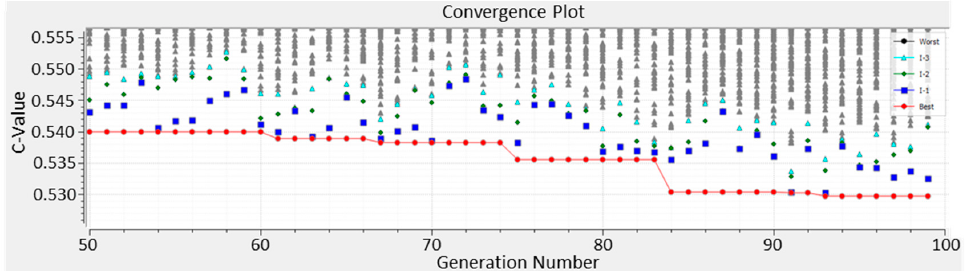
Figure A1. Results of the single objective optimisation of minimising C-value of the precinct by varying the orifice outlet sizes. Table A3. Comparison of gravel storage utilisations for the optimised precinct model and base precinct model.